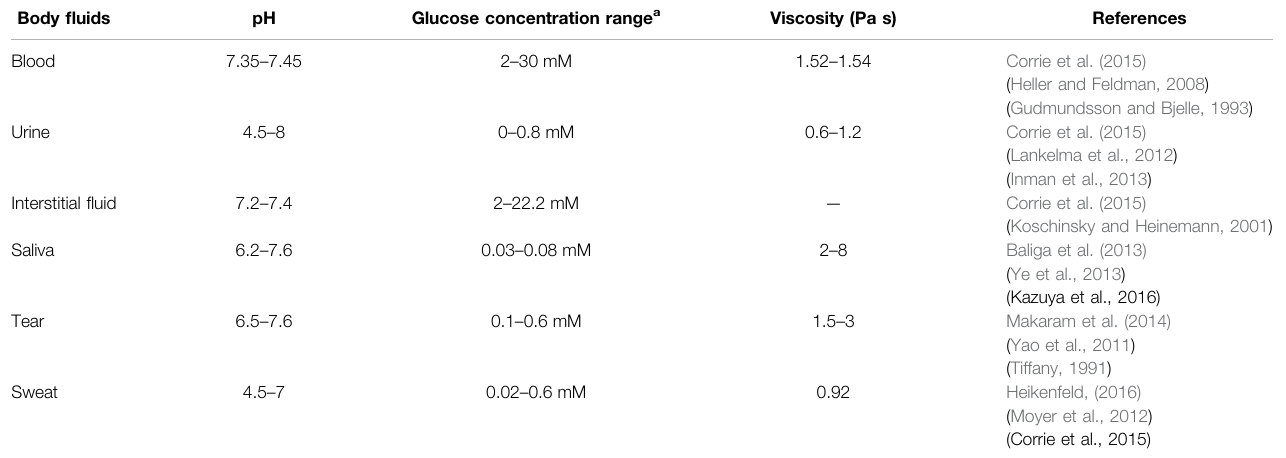
TABLE 1 | The physiological concentration of glucose in different fl